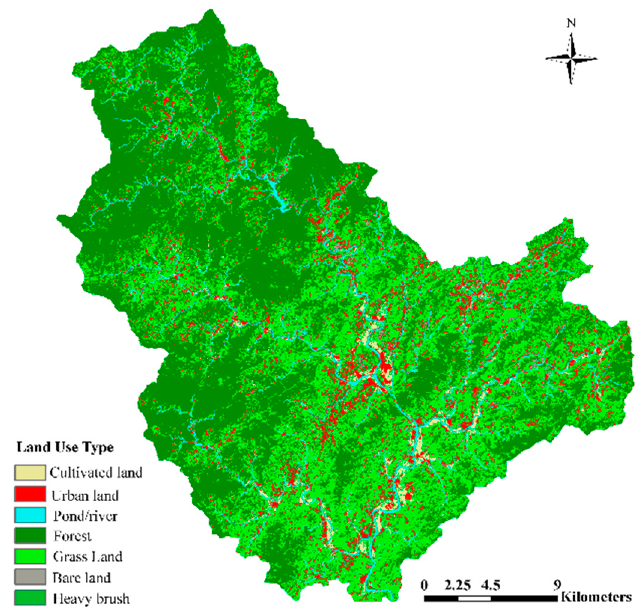
Figure 3. Map of the Misai basin